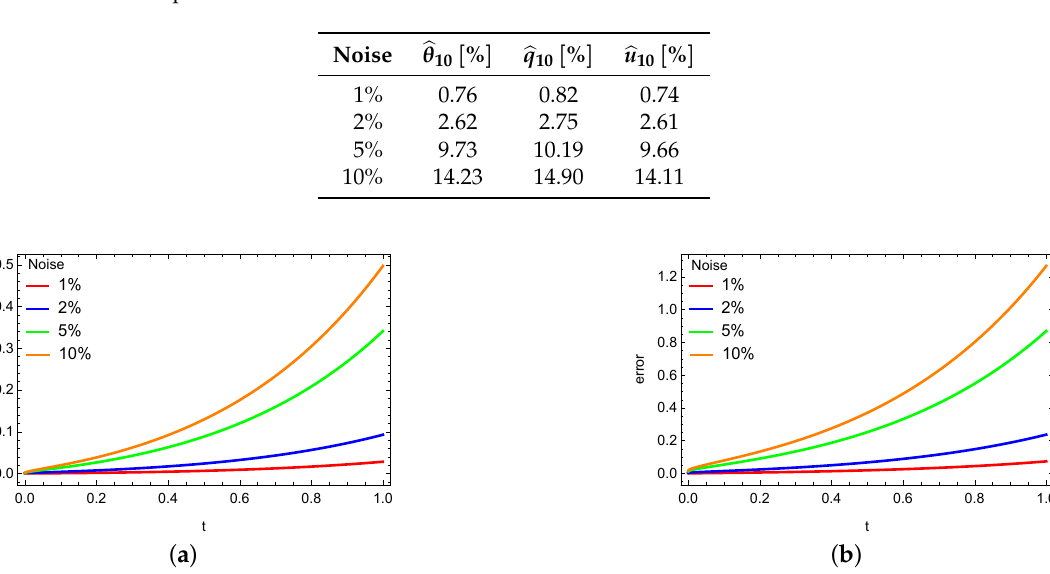
Figure 7. The reconstructed boundary conditions for the various noise of input data: ( a ) temperature distribution θ , ( b ) heat flux q . Table 1. The relative errors of reconstruction the boundary conditions and temperature distribution for the disturbed input data.